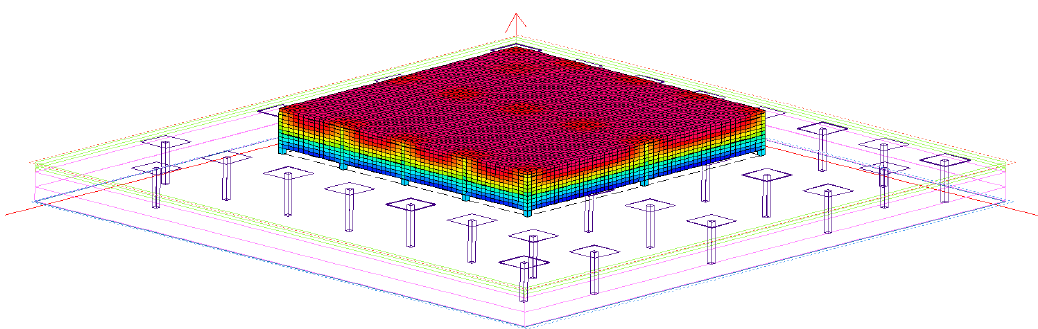
Figure 5. A section of 1A assembly shown with temperature variations in 3D.